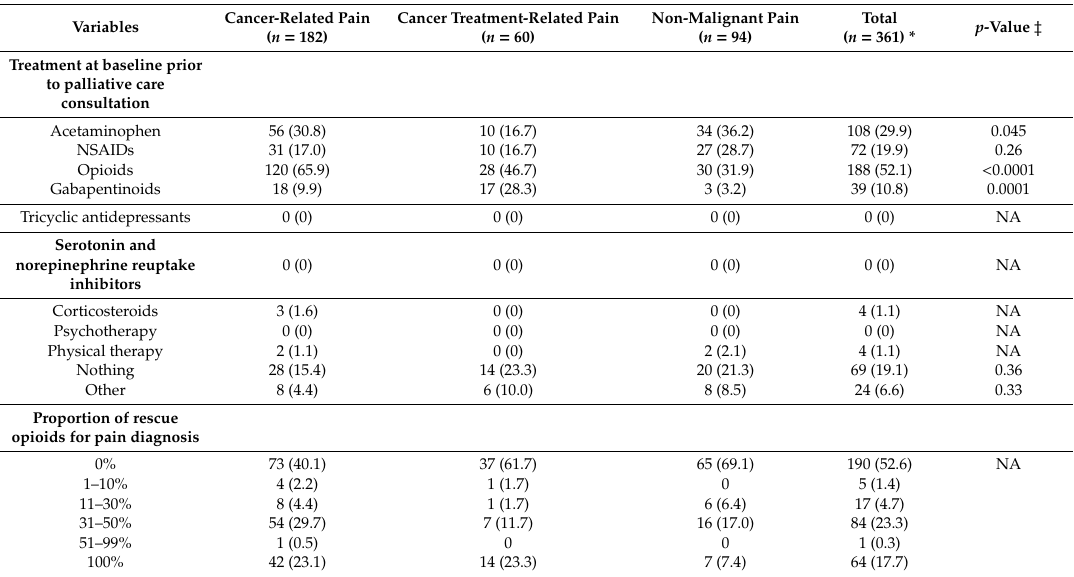
Table 3. Treatment for pain diagnoses ( n =